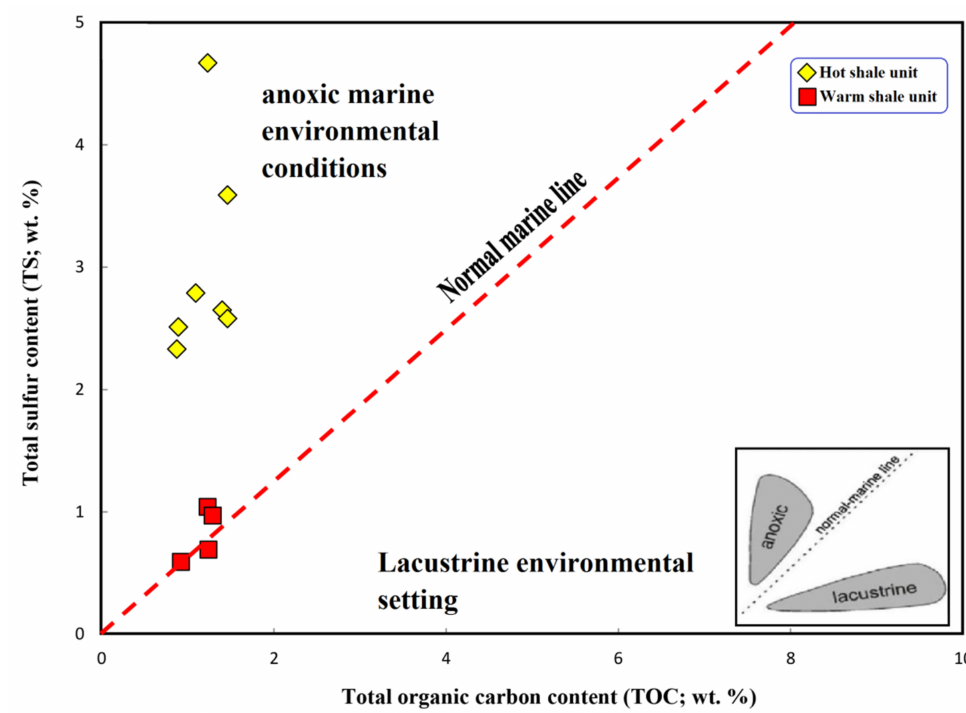
Figure 14. Relationship between TOC and TS content for the analyzed shales of the Qusaiba units, showing normal to anoxic marine environmental conditions.